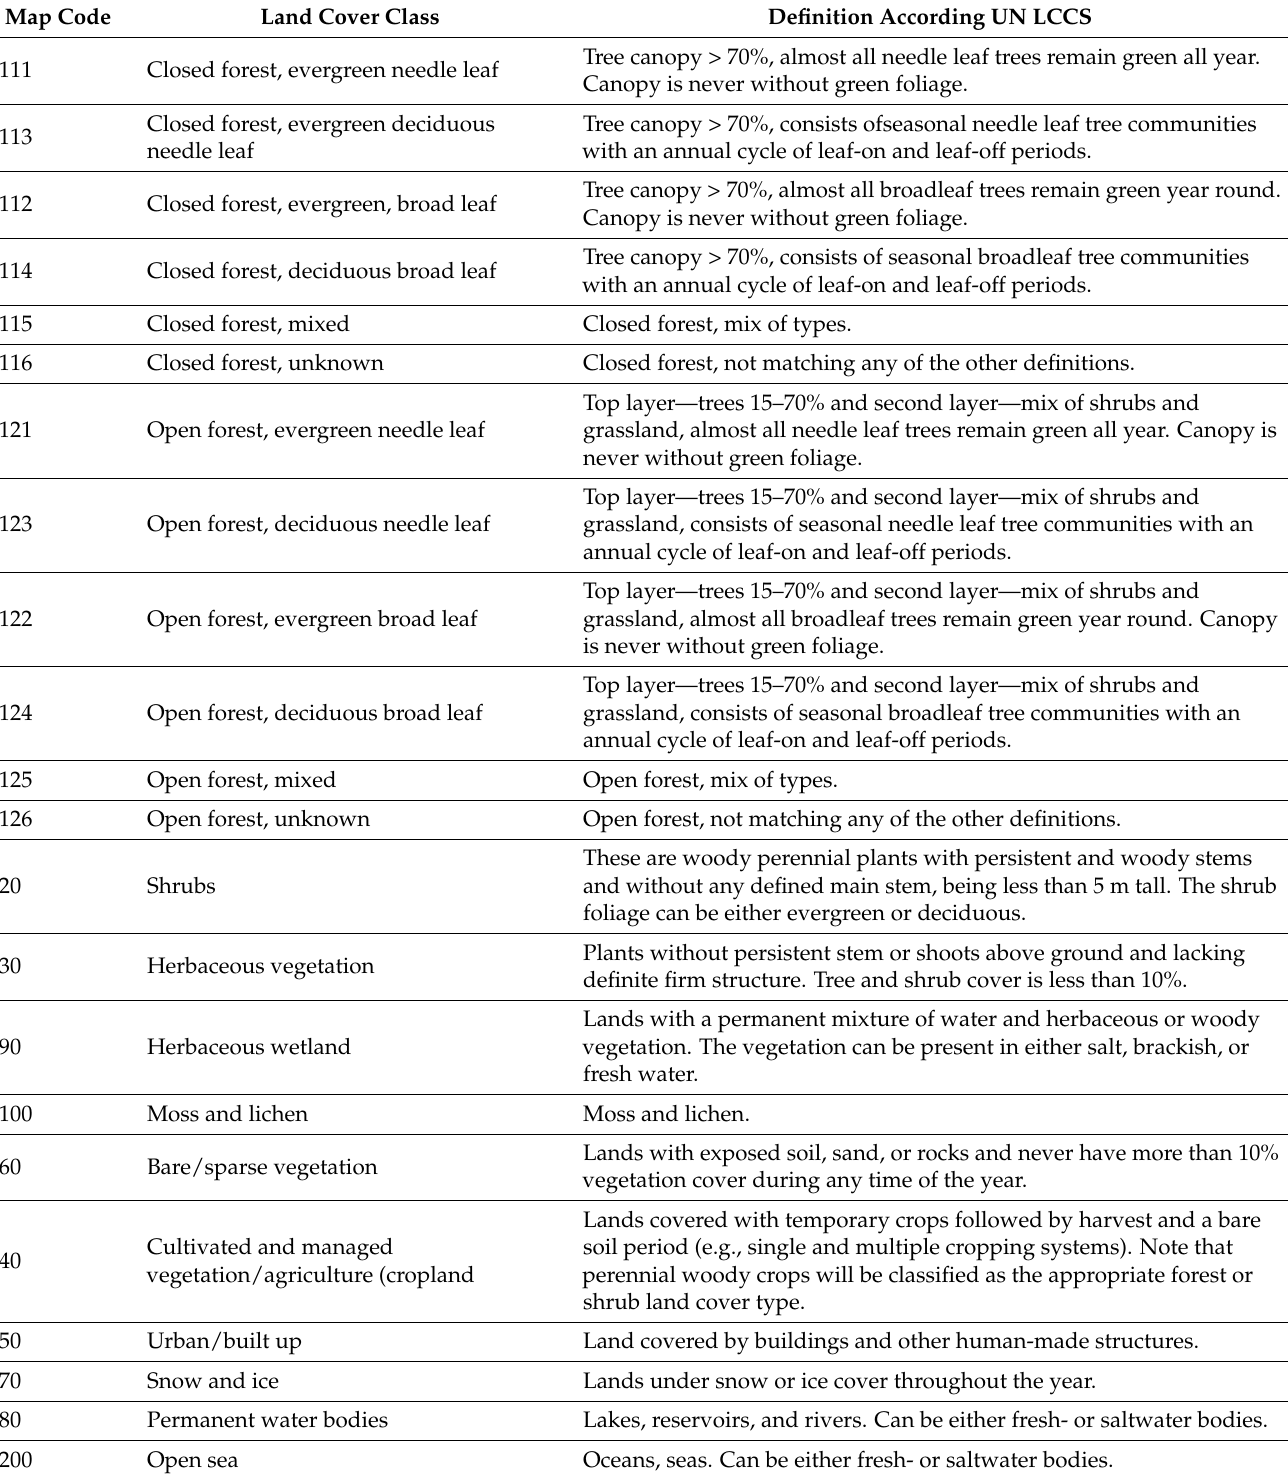
Table A1. Land cover classes included in